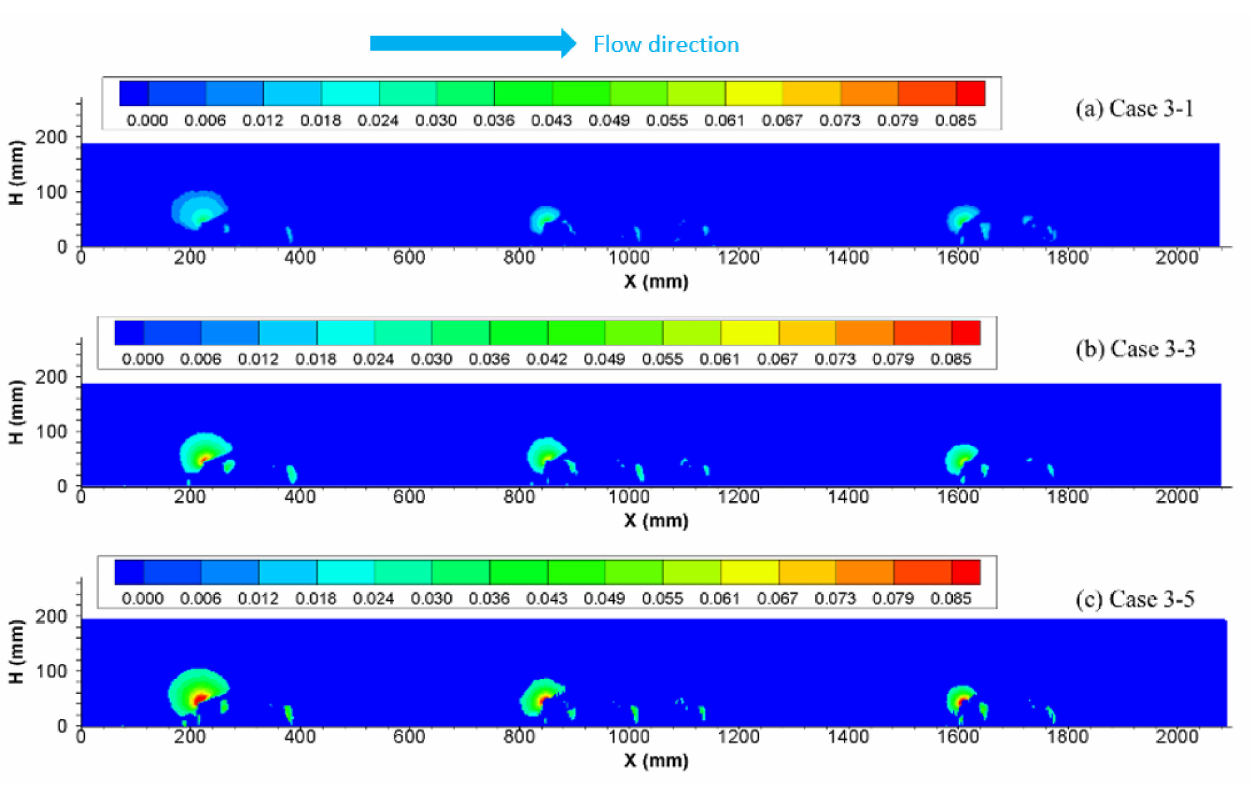
Figure 8. Upwelling area of M-shaped unit reef under different conditions. ( a ) Case 3-1; ( b ) case 3-3; ( c ) case